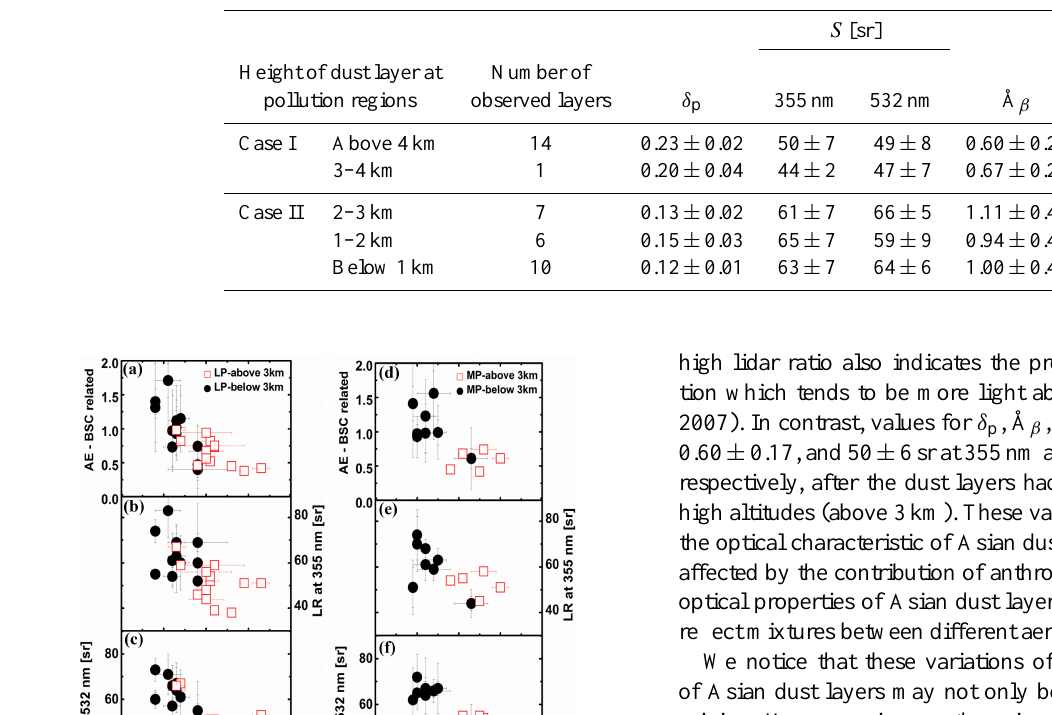
Table 2. Linear particle depolarization ratio at 532nm, lidar ratios, and backscatter-related Ångström exponents of East Asian dust layers according to the altitude range in which these plumes passed over polluted regions of China. Case I describes the layer from 3 to 4 and above 4km. Case II describes the layers from 0 to 1, 1 to 2, and 2 to 3km height above ground.